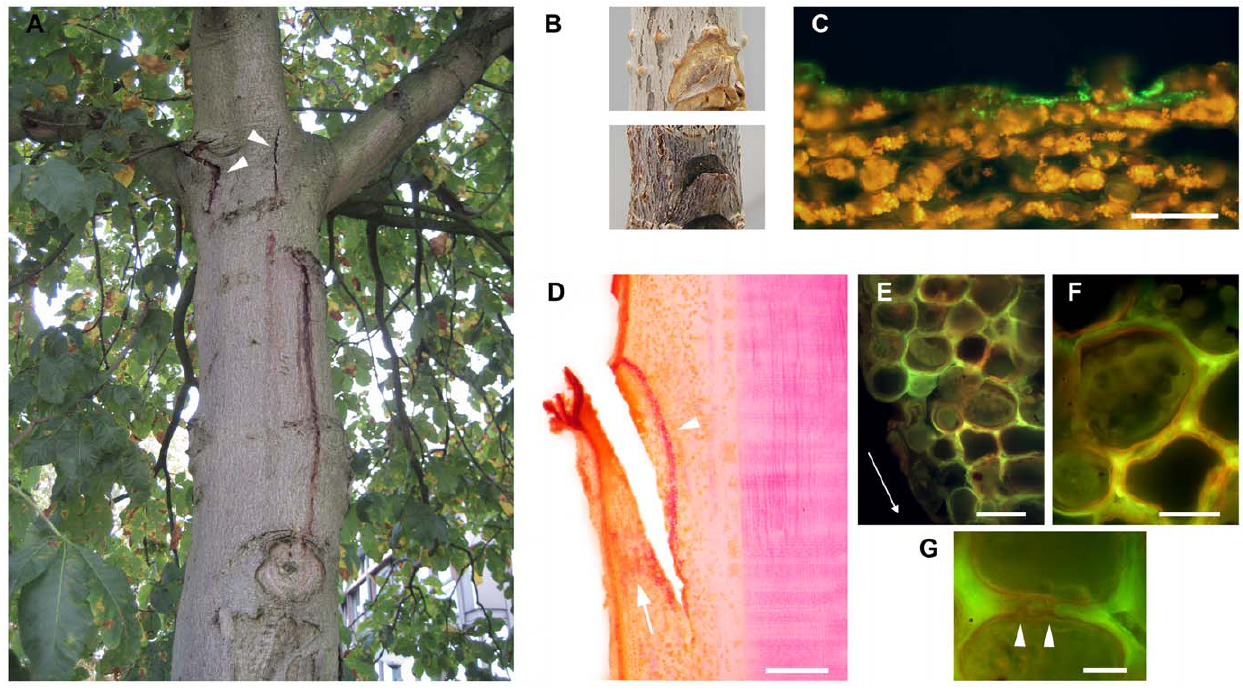
Figure 1. Bleeding disease of horse chestnut and biogenesis of a structural barrier after wounding. (A) Typical symptoms of P. syringae pv. aesculi associated bleeding disease observed on the trunk of an A. carnea tree, including bleeding of amber coloured sap and cracking of the bark (arrowheads). Photo taken in Sept. 2008 at N51 u 57 9 26 0 ; E5 u 34 9 10 0 . (B) Appearance of surface wounds on A. hippocastanum seedlings mock- inoculated (top panel) or inoculated with P. s. pv. aesculi PD5126 (bottom panel) after 3 months. While the seedling bark recovers when mock- inoculated by regeneration of periderm, the wounded tissue appears blackened and sunken when inoculated with P. s. pv. aesculi . (C) Immunofluorescent labelling of a transverse section of the wound area sampled directly after inoculation of P. s. pv. aesculi PD4818 (t=0) indicates that the bacteria (green) only colonize the outermost cell layer after inoculation. The scale bar indicates 100 m m. (D) A longitudinal section of a mock- inoculated wound sampled after 6 days with phloroglucinol-HCl stained lignin (red/purple). A barrier zone composed of several lignified parenchyma cells wide is visible along the wound (arrowhead) along with a broad layer of diffusely lignified cells in the disjointed part (arrow). The scale bar indicates 0.5 mm. (E) Fluorescence microscopic observation on a longitudinal section of a wound sampled 8 days after PD4818 inoculation stained for waxes using Sudan IV. The cells that exhibit lignification, as seen by the yellow/green autofluorescence, also show Sudan IV stained suberin lamellae that appear in dim red. The arrow reflects the direction of the original inoculation cut. The scale bar indicates 50 m m. (F) Detail of E showing the even deposition of suberin around the plant protoplasts. The scale bar indicates 25 m m. (G) Continuous deposition of suberin by two cells at pit fields (arrowheads). The scale bar indicates 10 m